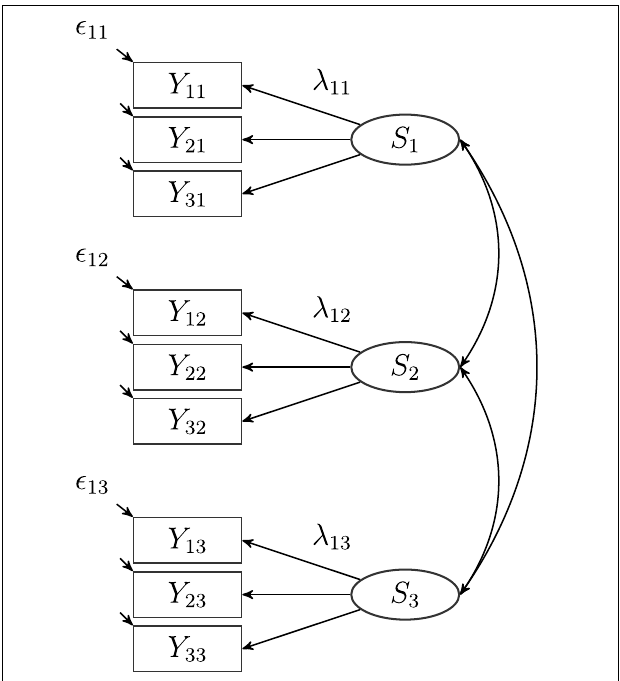
FIGURE 1 | A latent state (LS) model with three indicators ( i = 3) and three occasions of measurement ( l = 3), where S l : latent state factors, (cid:3) λ il : latent state factor loadings, il : measurement error variables. Intercepts ( α il ) are not depicted in the